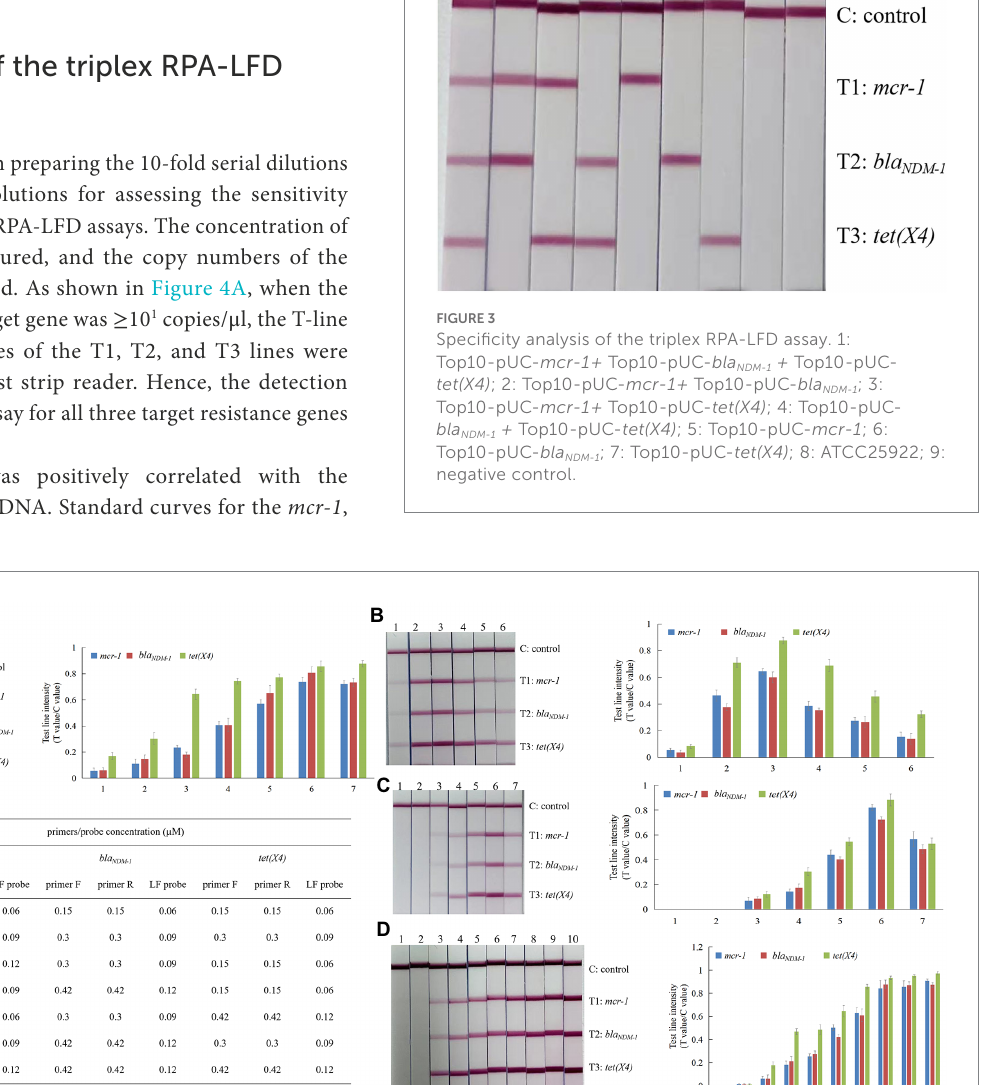
FIGURE 2 Optimization of triplex RPA amplification conditions. (A) Concentration of primer/LF probe; (B) reaction temperature (1–6: 30, 35, 37, 39, 45, 50 ° C); (C) concentration of magnesium-acetate (1–7: 0, 2.8, 5.6, 8.4, 11.2, 14, 16.8 mM); (D) reaction time (1–10: 0, 2.5, 5, 7.5, 10, 12.5, 15, 20, 25, 30